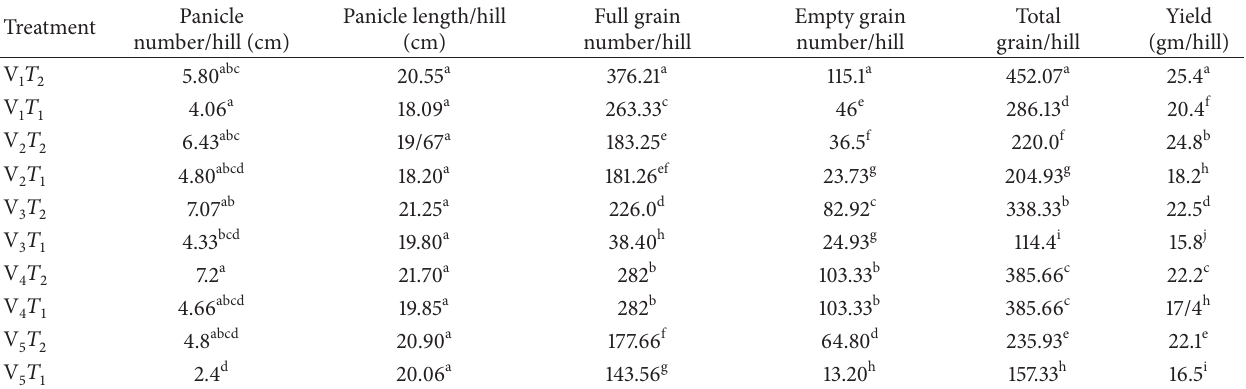
Table 4: Interactive effects between cultivar and temperature on yield and yield